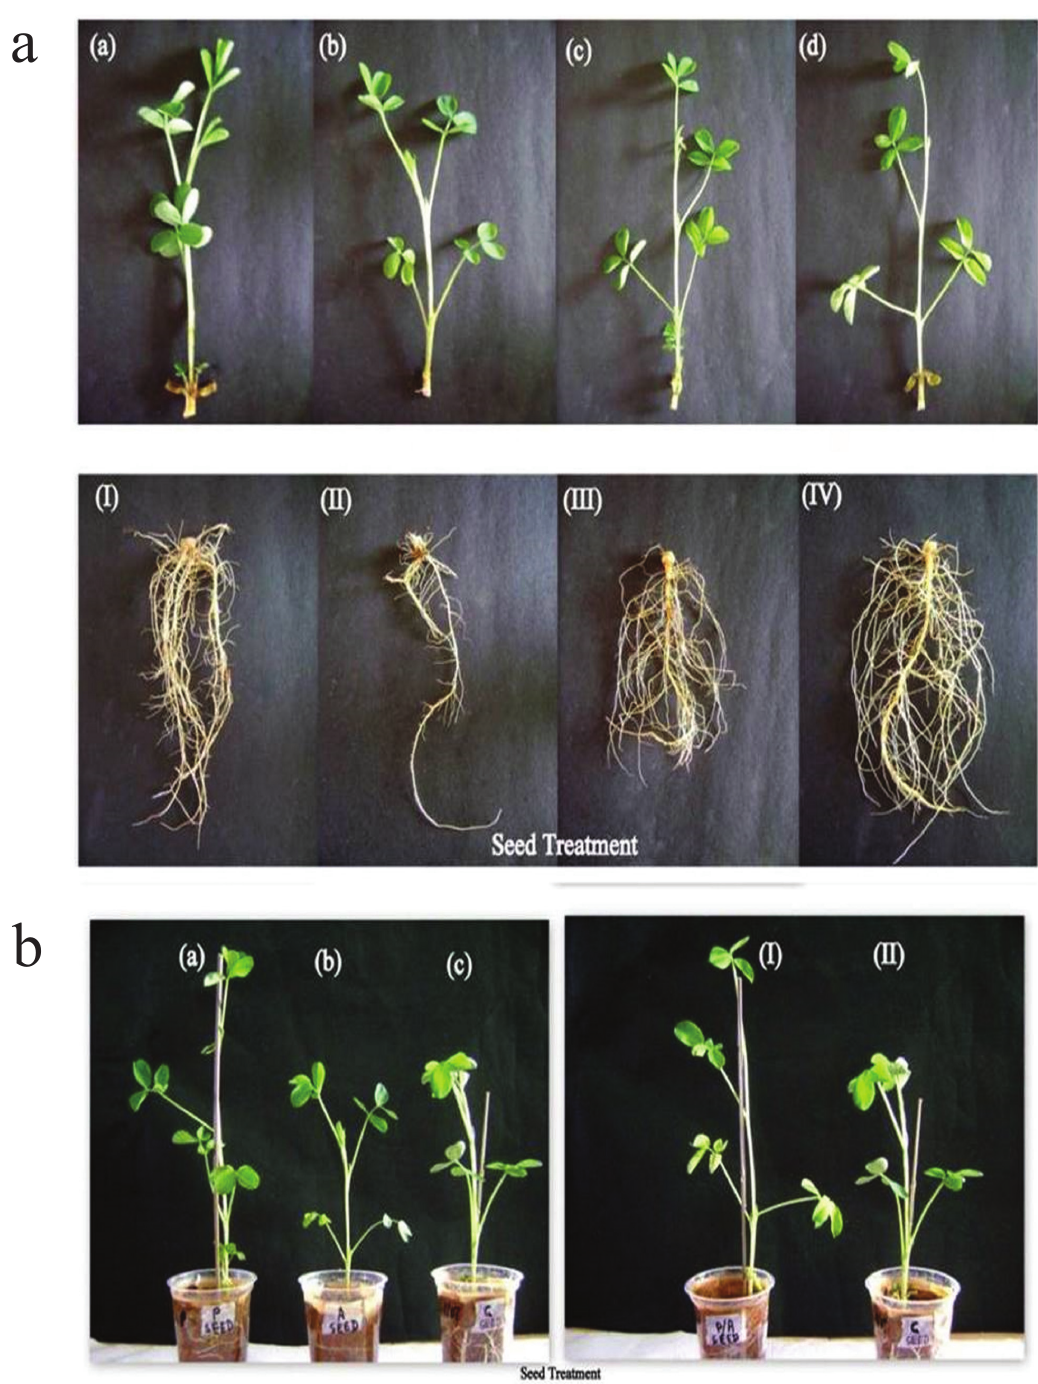
Figure 3 - Growth of groundnut plants under seed treatment with PGPR. a . Root and shoot growth of groundnut under seed treatment with PGPR. (a) and (I) – Control; (b) and (II) – A. brasilense ; (c) and (III) – P. fluorescens ; (d) and (IV) – A. brasilense and P. fluorescens. b . Groundnut plants after seed treatment with PGPR. (a) – P. fluorescens ; (b) – A. brasilense ; (c) – Control; (I) – A. brasilense and P. fluorescens; (II) -